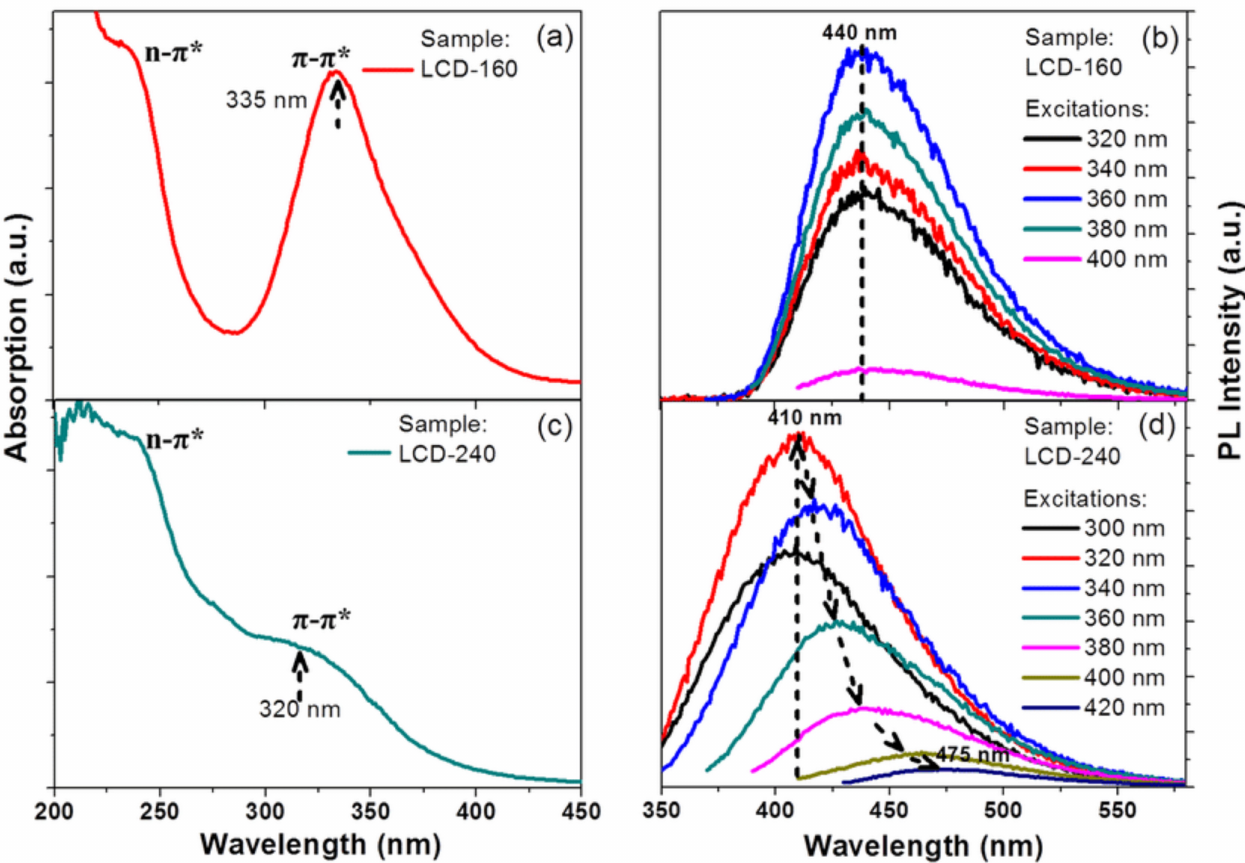
Figure 8. ( a ) and ( c ) UV-Vis absorption spectra of CQDs obtained at reaction temperature 60 and 240 ◦ C; ( b ) and ( d ) PL spectra demonstrating independent and dependent behavior. Reproduced with permission from ref. [111], published by Scientific Reports,